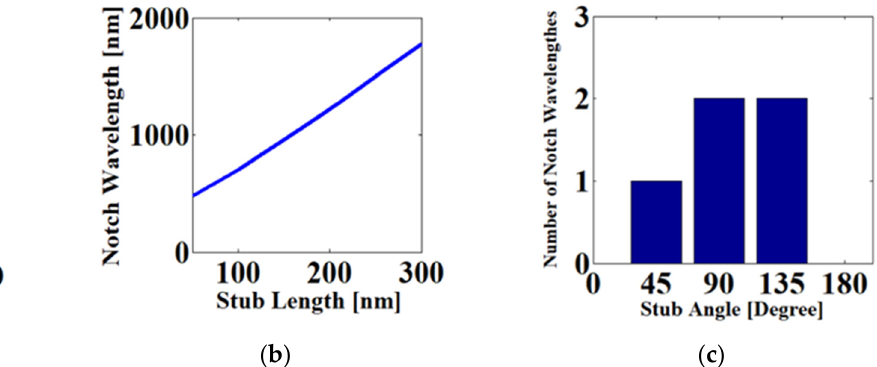
Figure 1. The relationship between the stub dimensions and the notch wavelength ( a ) stub width, ( b ) stub length, and ( c ) stub rotation angle. ( b ) stub length, and ( c ) stub rotation